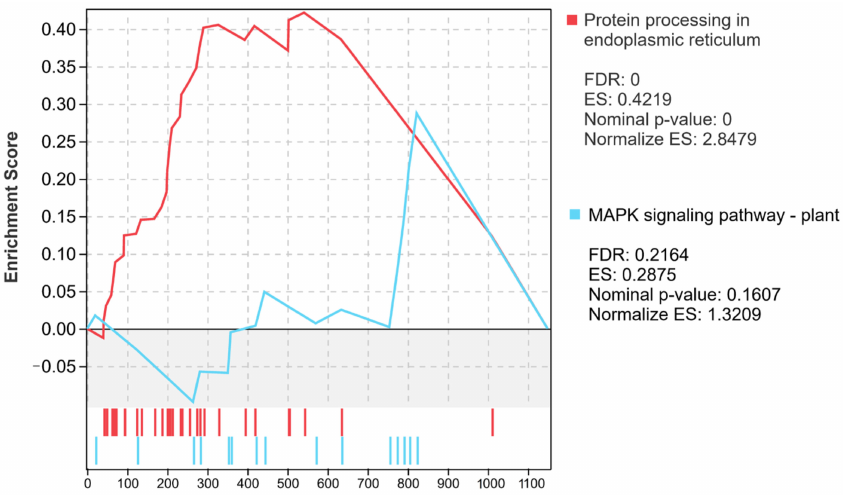
Figure 10. GSEA of up-regulated DEGs in haploid ginkgo.